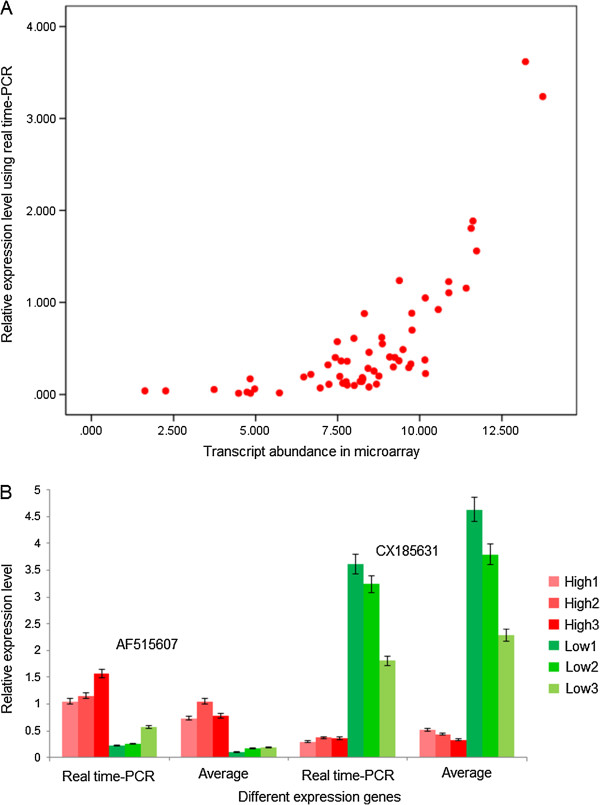
Validation of selected candidate genes using real time-PCR. We selected ten genes for validation by real time-PCR: CF936190, AF515607, CK089075, CV273041 and CV260219A are the up-regulated genes, and AJ780277, CX183751, CX185631, CV260015 and DN487027 are the down-regulated genes in high photosynthetic rate gene pools. (A) The scatter plot show the relationship between transcript abundance of candidate genes in microarray and the relative expression level using real time-PCR, for which the template was the mixed cDNA of BSA (bulked segregant analysis) pools. (B) The relative expression level using real time-PCR, for which the template was the mixed cDNA of BSA pools and the templates were from the individuals used for constructing BSA pools. Error bars represent the standard deviation. Real time-PCR expression analysis with ANOVA indicated significant differences between the groups with high and low photosynthetic rate (Additional file 7: Table S4), generally consistent with the expression patterns identified by the microarray. The trends are consistent between Real time-PCR expression measured in the gene pool and relative individuals (constructing these gene pools) in general (r = 0.939).